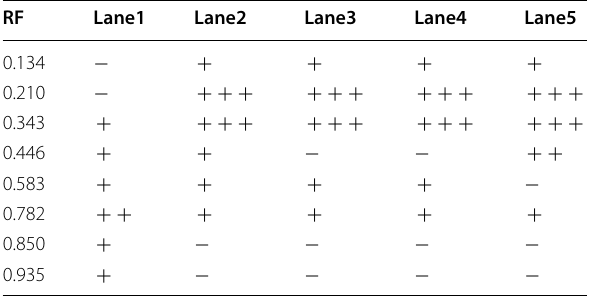
Table 3 Effect of A . terreus on peroxidase isozyme of S.